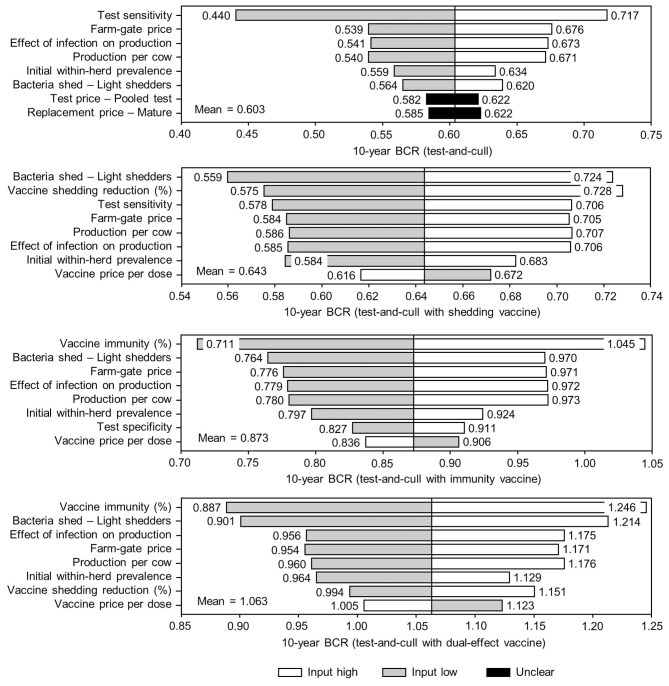
Sensitivity of 10-year benefit-cost ratios (BCRs) associated with various JD (paratuberculosis) control practices involving testing and culling in average Canadian dairy herds to a range of input variables. Assumes initial mean values of 10% for within-herd Mycobacterium avium subsp. paratuberculosis (MAP) infection prevalence, 50% for herd-level prevalence, 50% for vaccine efficacies, and 50% for testing sensitivities. The color of the sensitivity bars indicates the direction of the relationship between the variable and 10-year BCR (grey indicates the effect of variable values below their mean value, white indicates the effect of values above their mean, and black indicates that the effect is unclear).